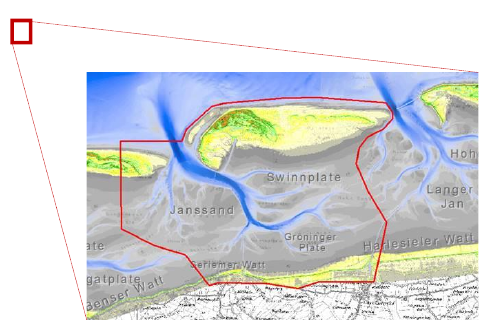
Figure 2. Geolocation of the study area Otzumer Balje, a tidal basin in the German Wadden